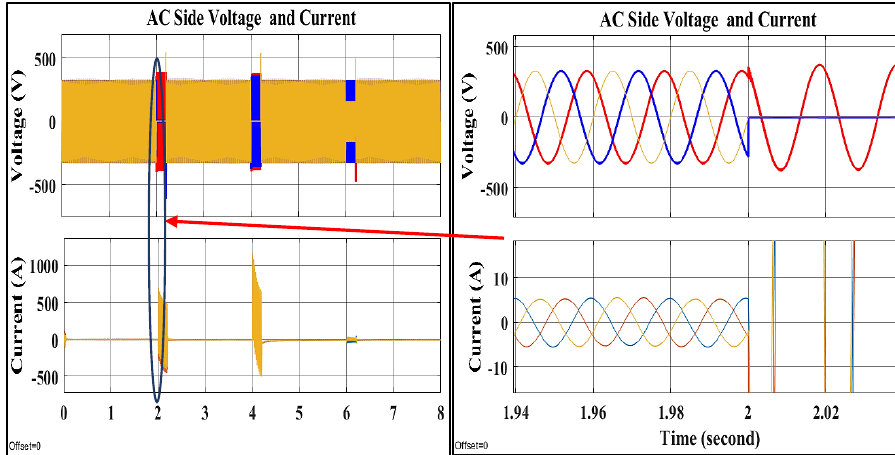
Figure 20. Three-phase AC bus current and voltage under fault conditions .